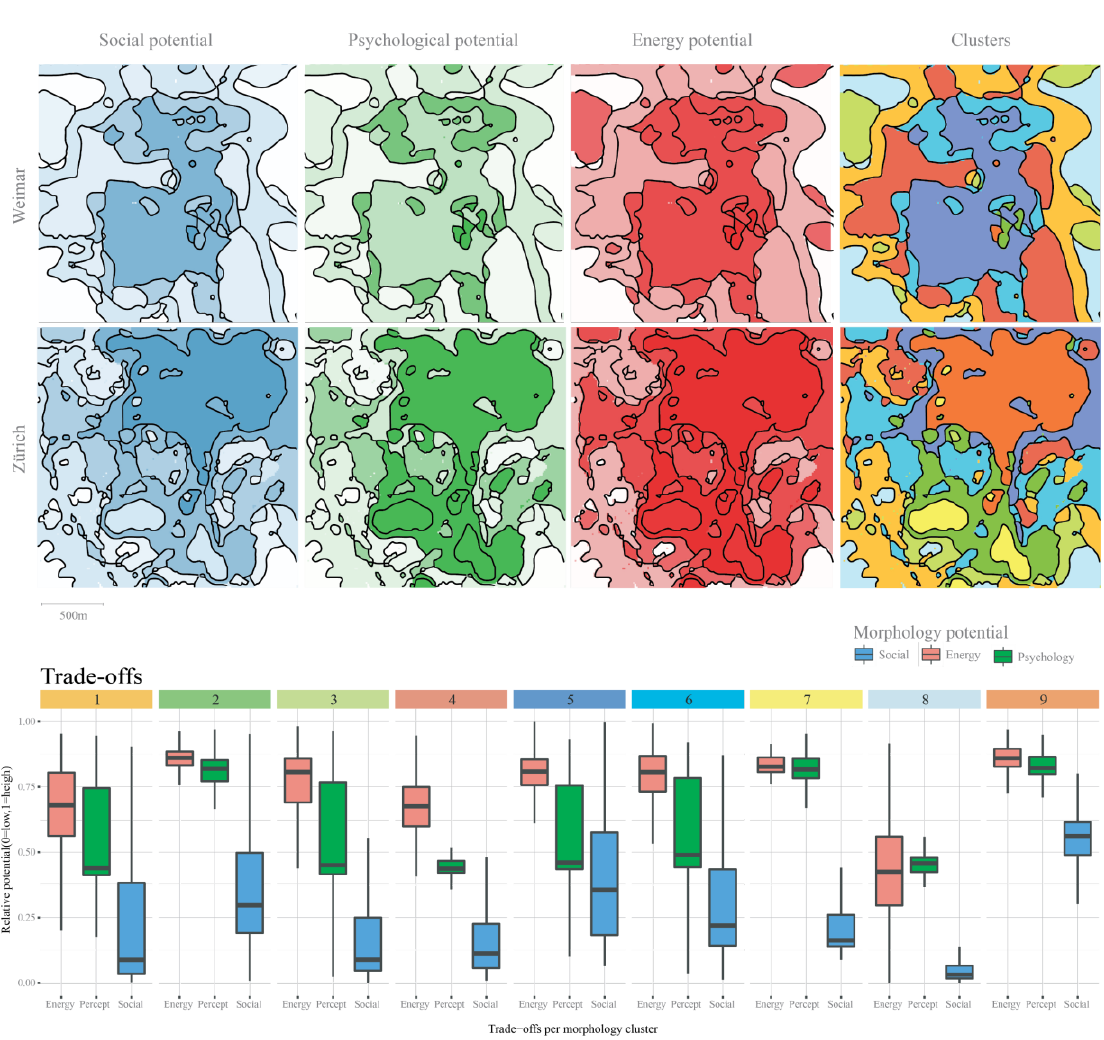
Figure 19. The average social, psychological, and energy potentials mapped for each cluster (Dark color = high potential, Light color = low potential). Box plots display the distribution of potentials per cluster. The box width illustrates the number of elements in the cluster.